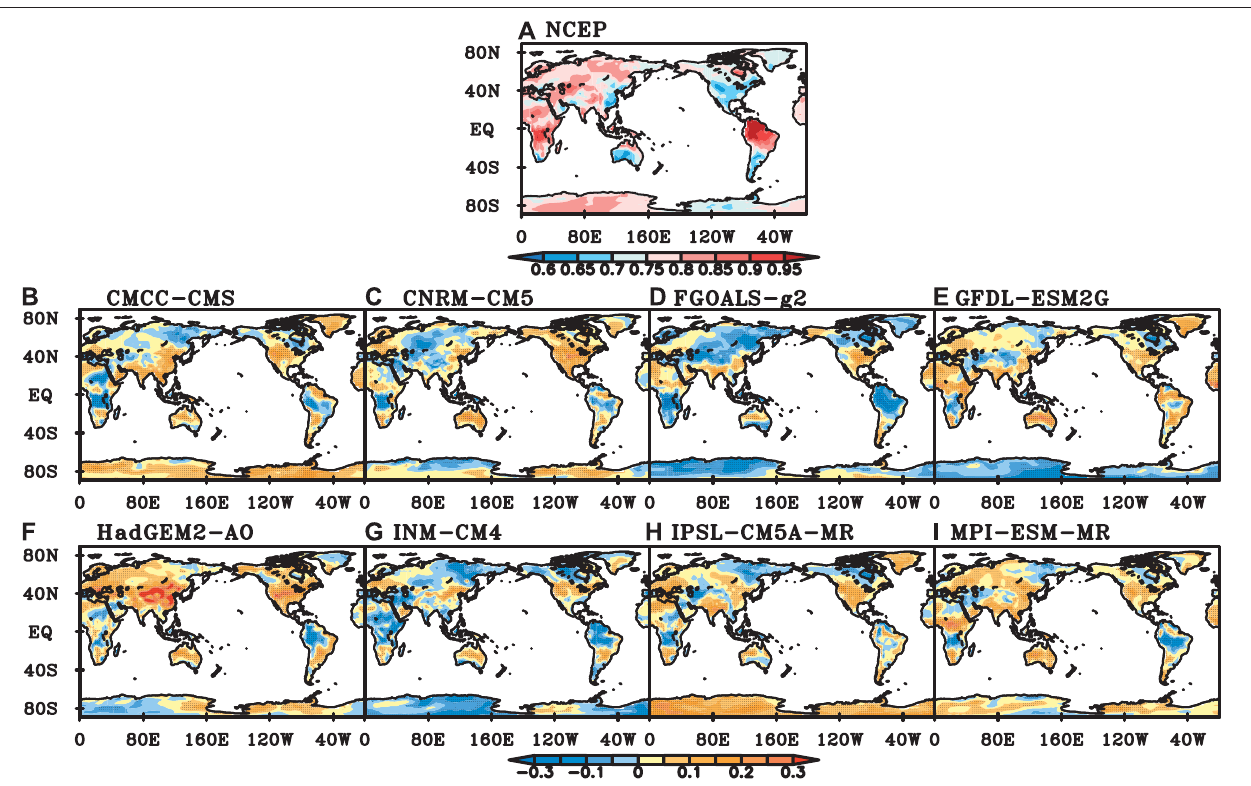
FIGURE 10 | Scaling exponents ofNCEP SAT (A) and difference between NCEP and those of SAT simulated by (B) CMCC-CMS, (C) CNRM-CM5, (D) FGOALS- g2, (E) GFDL-ESM2G, (F) HadGEM-AO, (G) INM-CM4, (H) IPSL-CM5A-MR, (I) MPI-ESM-MR in winter. (Black dot represents the difference is signi fi cant at a signi fi cance level of